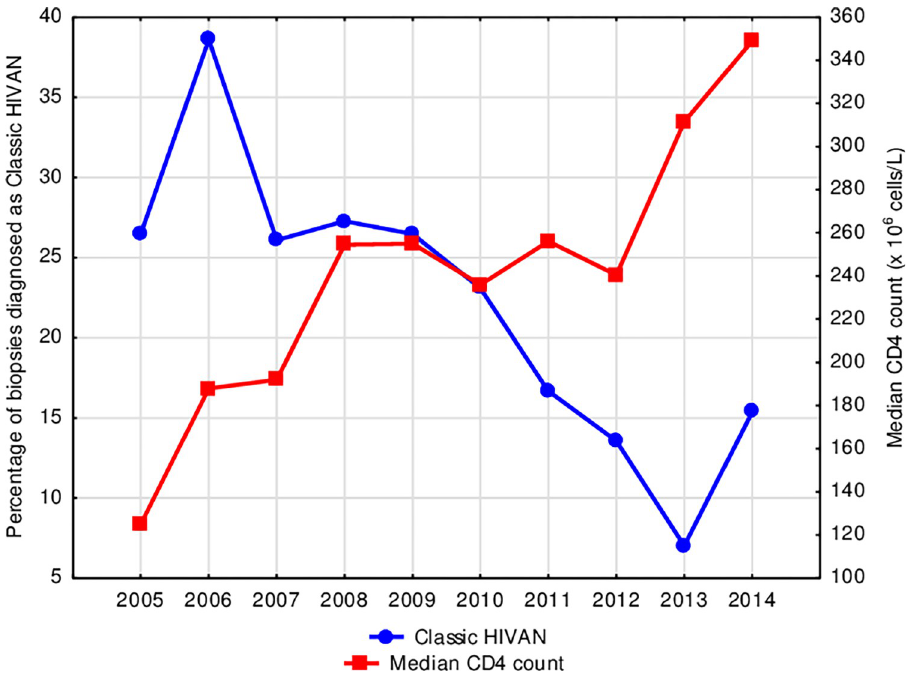
Fig 1. Median CD4 count and annual incidence of classic HIVAN in HIV-positive patients who underwent a native kidney biopsy following ART rollout in 2004.